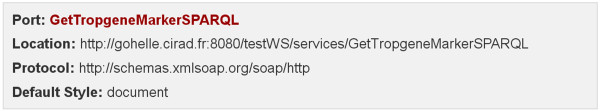
General information about the GetTropgeneMarkerSPARQL Web Service registered in the BioCatalogue.